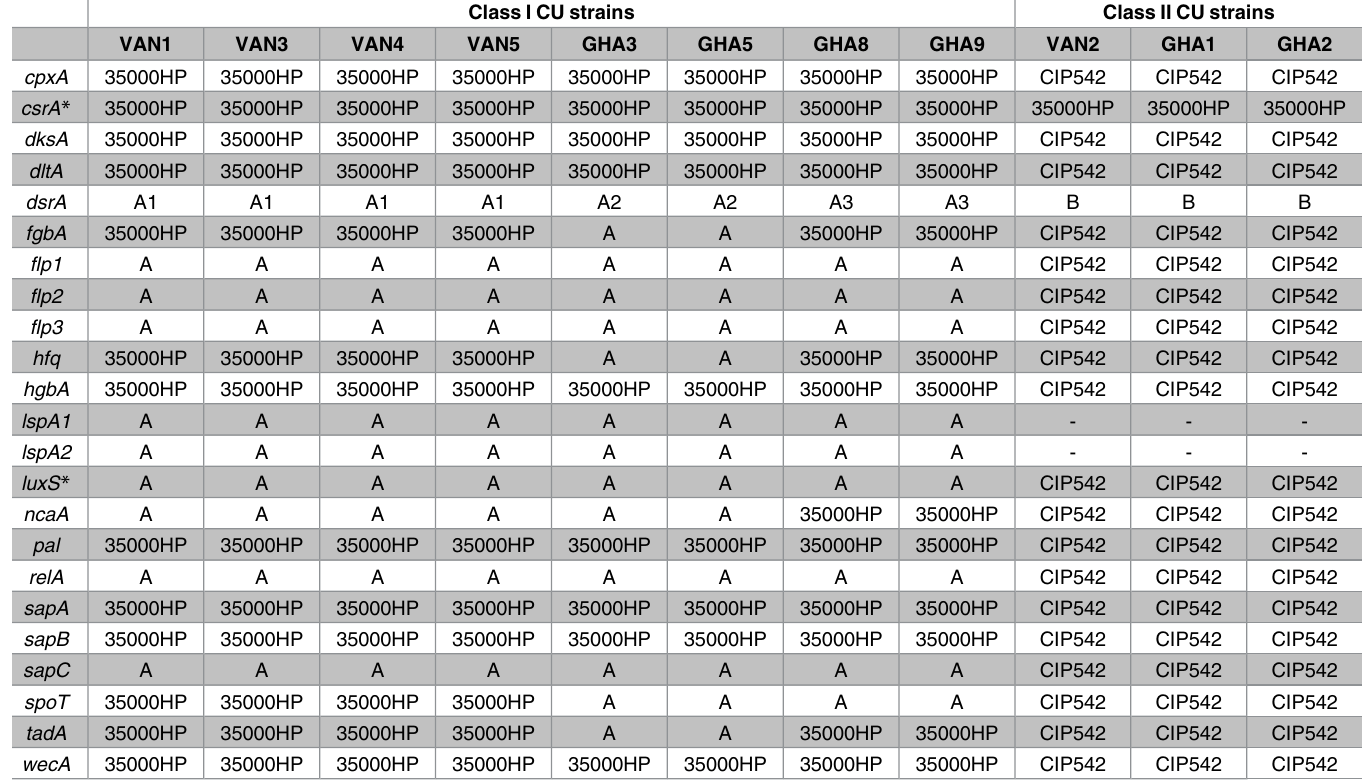
Table 1. Comparison of the virulence genes of the uncharacterized CU strains to that of 35000HPand